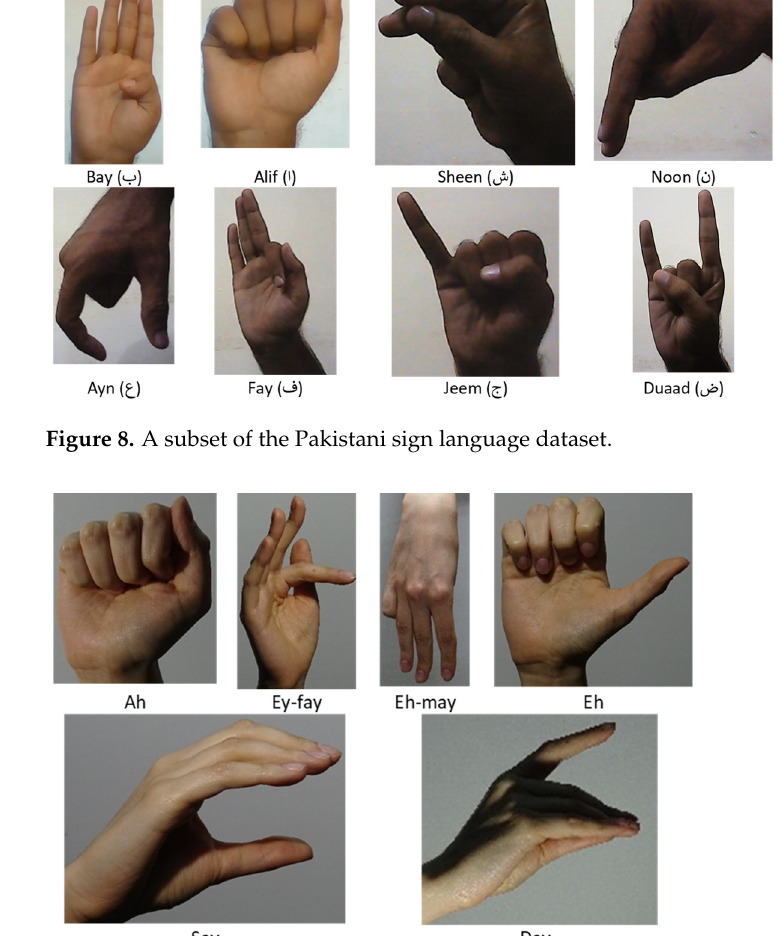
Figure 9. A subset of the Spanish sign language dataset.